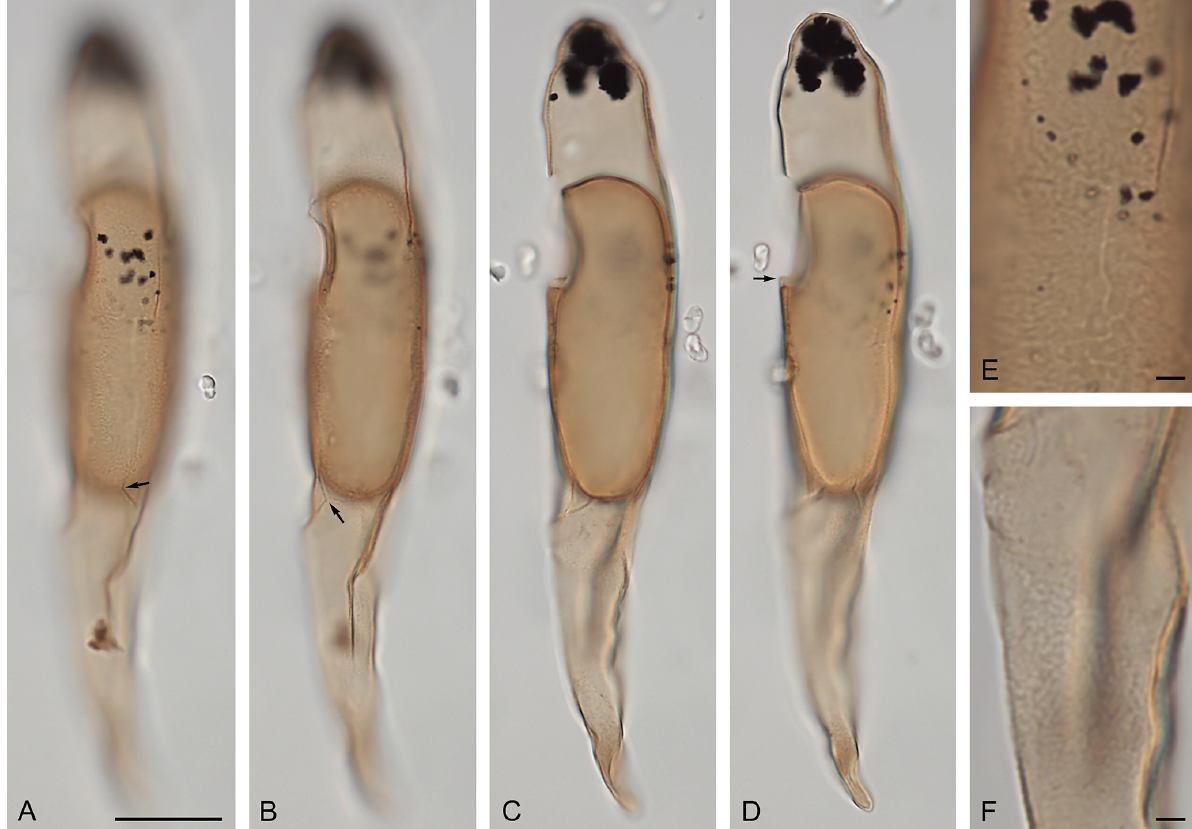
Plate 3. (A–F) Svalbardella sp. cf. S. partimtabulata Heilmann-Clausen and Van Simaeys, 2005. Right lateral view (A–D) at upper- through mid-foci, with margin between postcingular and antapical plate series shown by arrows (A, B) , adcingular margin of periarcheopyle over- lapping that of endoarcheopyle shown by arrow (D) , and detail of wall surface on central body (E) and antapical horn (F) ; Renardodden, Spitsbergen; slide MCP 2276(5); EF: M41/2; cyst length: 151µm. Scale bar = 2µm in (E) , (F) .